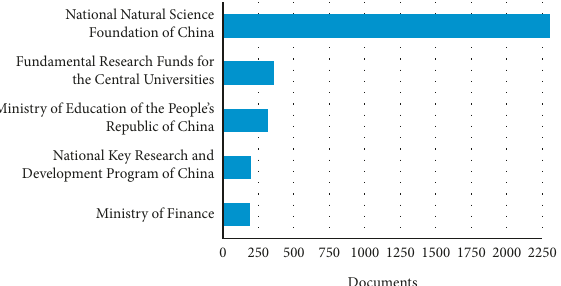
Figure 8: Top funding organizations sponsoring PSOA